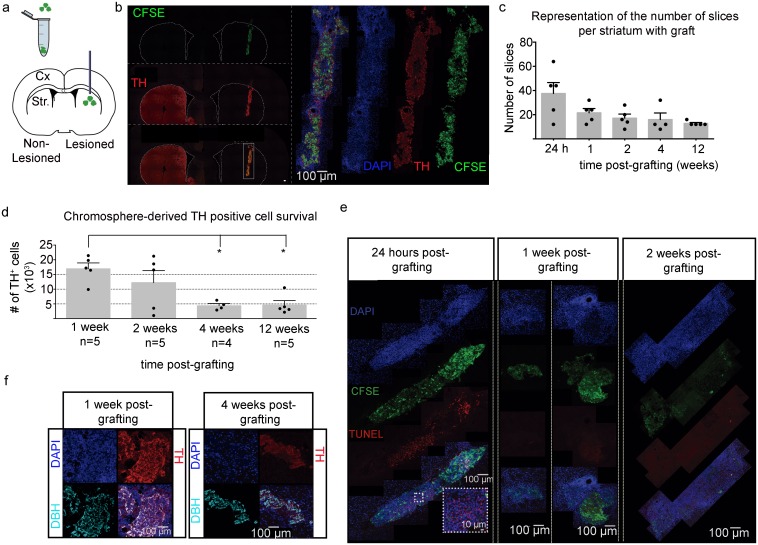
Survival and TH expression of chromospheres grafted into the striatum of 6-OHDA lesioned rats.(a) Schematic representation of the grafting site. Chromosphere cells were loaded with a green fluorescent dye (CFSE) before grafting, and stereotaxically implanted into the lesioned striatum (Str). Cx (cortex). (b, left panel) Representative reconstruction of a coronal section of the striatum from a 6-OHDA-lesioned animal with grafted chromospheres after immunofluorescence staining for TH (red). Both lesioned (right) and non-lesioned (left) hemispheres are shown. The top panel shows CFSE fluorescence (green), the middle panel shows TH immunofluorescence and the lower panel is the merge. Images at 10x magnification were obtained with an epifluorescence microscope. The reconstruction was done automatically using an automatic platina. The scale bar is 100 μm. (b, right panel) Representative reconstruction at higher magnification (40x) of a chromosphere graft obtained from the same coronal section as in the left panel using a confocal microscope. The reconstruction was done manually. DAPI (blue), TH immunostaining (red) and CFSE (green) are shown in separate channels and are merged in the top-left panel. (c) The number of coronal sections of the striatum found to contain grafted cells for each animal decreases during the first 24 h post-grafting. Striatal coronal sections of 40 μm were recollected in serial order and every fourth section was used for TH immunostaining or every two sections for those cases where the graft was smaller along the antero-posterior axis. 24 h (n = 5); 1, 2, 12 wpg (n = 5); 4 wpg (n = 4). (d) The TH+ surviving-grafted cells were counted directly from images obtained with 40x objective at 1, 2, 4 and 12 wpg (values obtained: 16 955 ± 1 978, 12 195 ± 4 129, 4 391 ± 729, 4 639 ± 1 497, respectively). Statistical differences are denoted by asterisks (ANOVA, P > 0.05, F = 5.685, r2 = 0.5321, p = 0.0083; followed by Tukey´s multiple comparisons post hoc test, P < 0.05*). (e) Representative confocal microscopy reconstructions showing grafted apoptotic cells marked with TUNEL (red) in coronal slices of the grafted striatum of animals at 24 h, 1 or 2 wpg. Grafted cells are shown in green as detected by CFSE fluorescence, and DAPI is shown in blue. The lower panel shows the overlay. All images were acquired using the same microscope settings and a 40x objective. Reconstructions of the grafted area were performed using a confocal microscope as described in (b). The insert framed by a dotted white square was obtained at 63x magnification from the section denoted by the dotted square in the image at lower magnification. (f) Representative double-immunofluorescence staining for TH (red) and DBH (cyan) in coronal sections from the striatum of two grafted animals at 1 and 4 wpg.